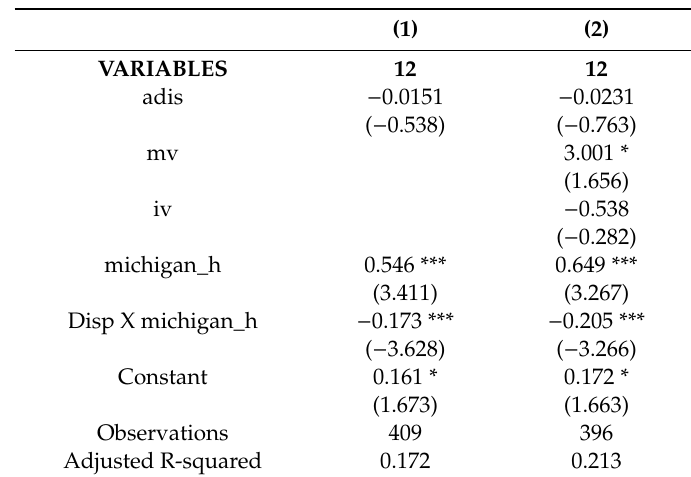
Table 11. Robustness check using Michigan consumer confidence